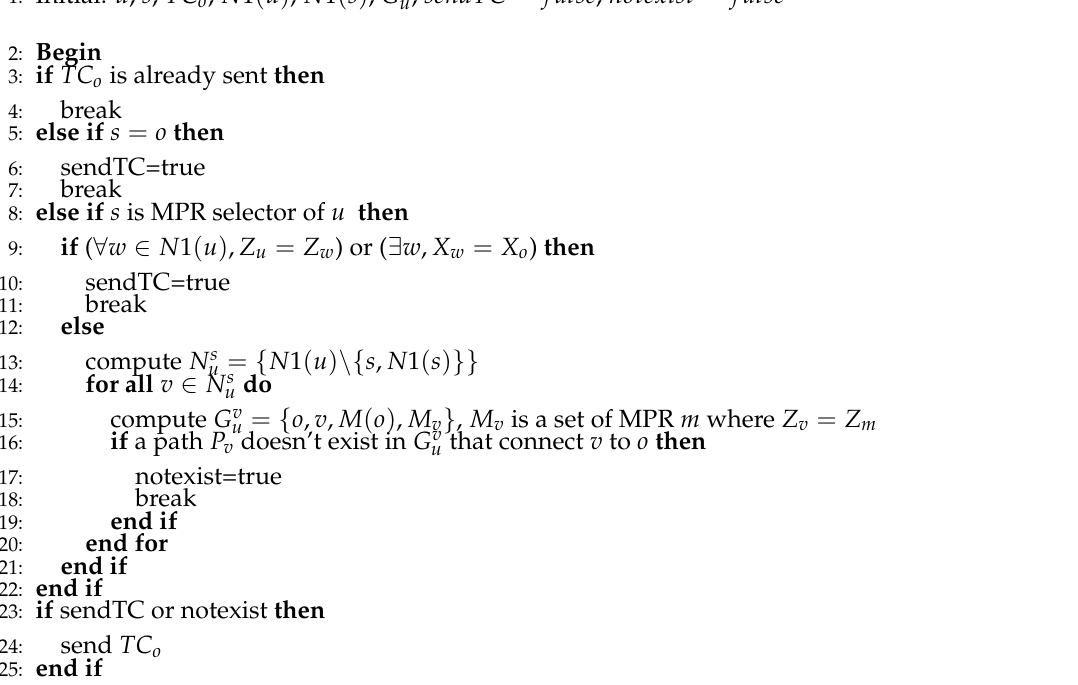
Algorithm 1 Geographic forwarding rules of modified